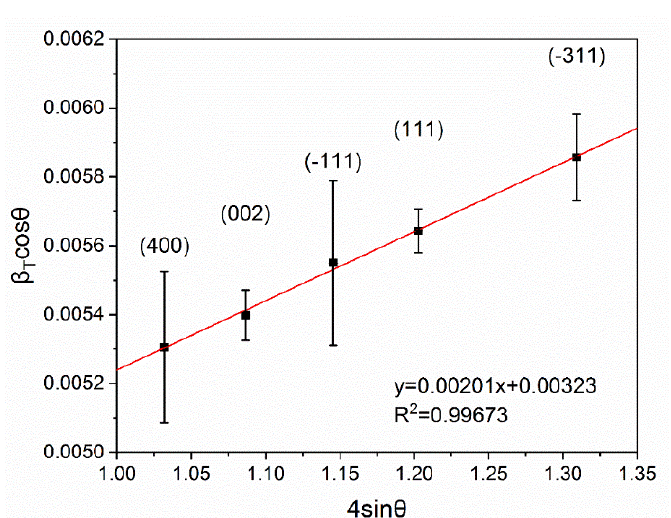
Figure 10. The Williamson–Hall plot of the β -Ga 2 O 3